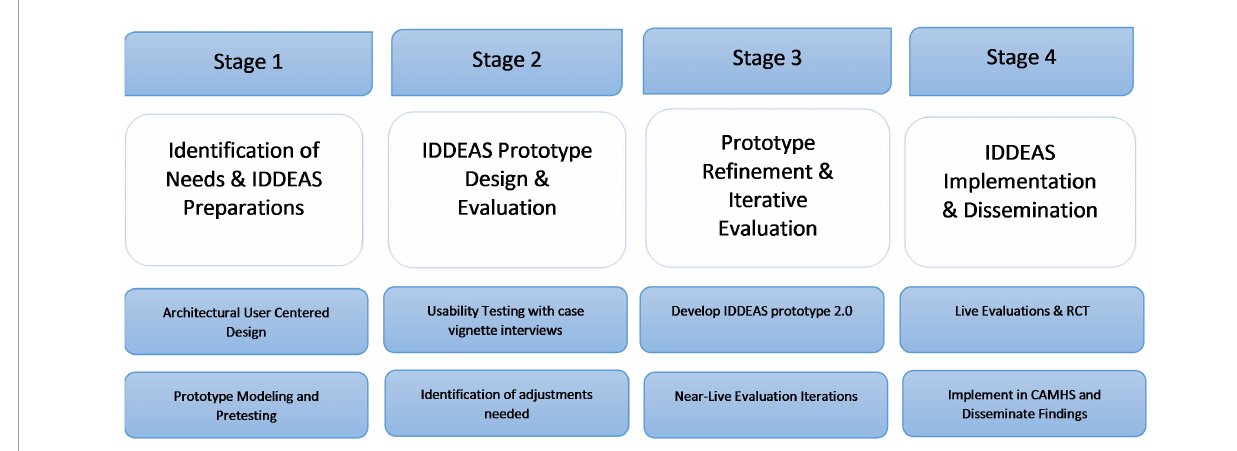
FIGURE1 Individualized Digital Decision Assist System (IDDEAS) project study design overview.